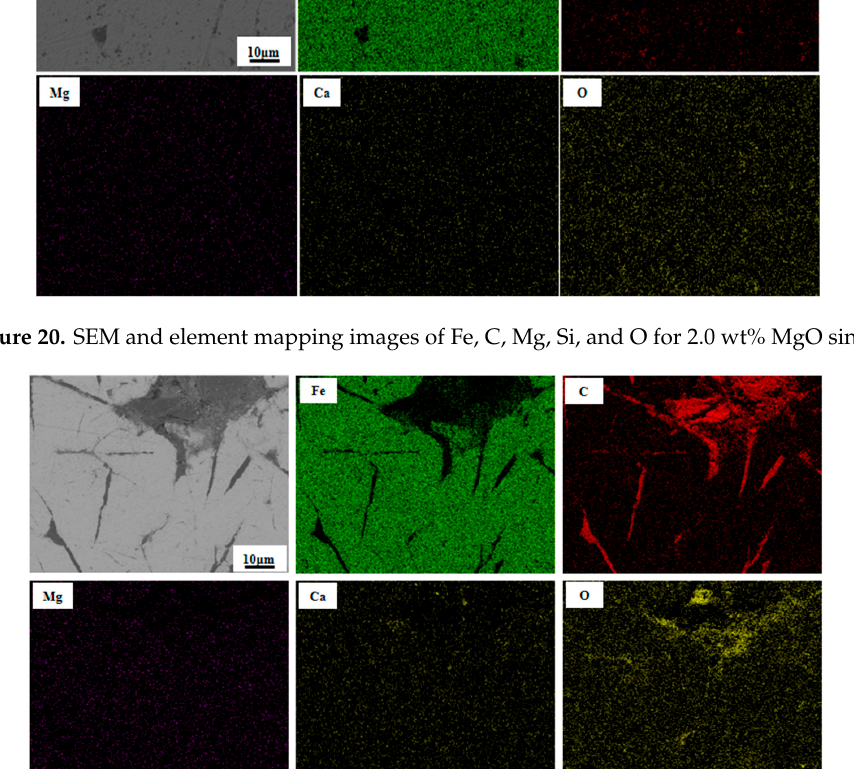
Figure 21. SEM and element mapping images of Fe, C, Mg, Si, and O for 1.3 wt% MgO sinter. Data of the chemical composition analysis of dripping and residual products for sinter with 1.3